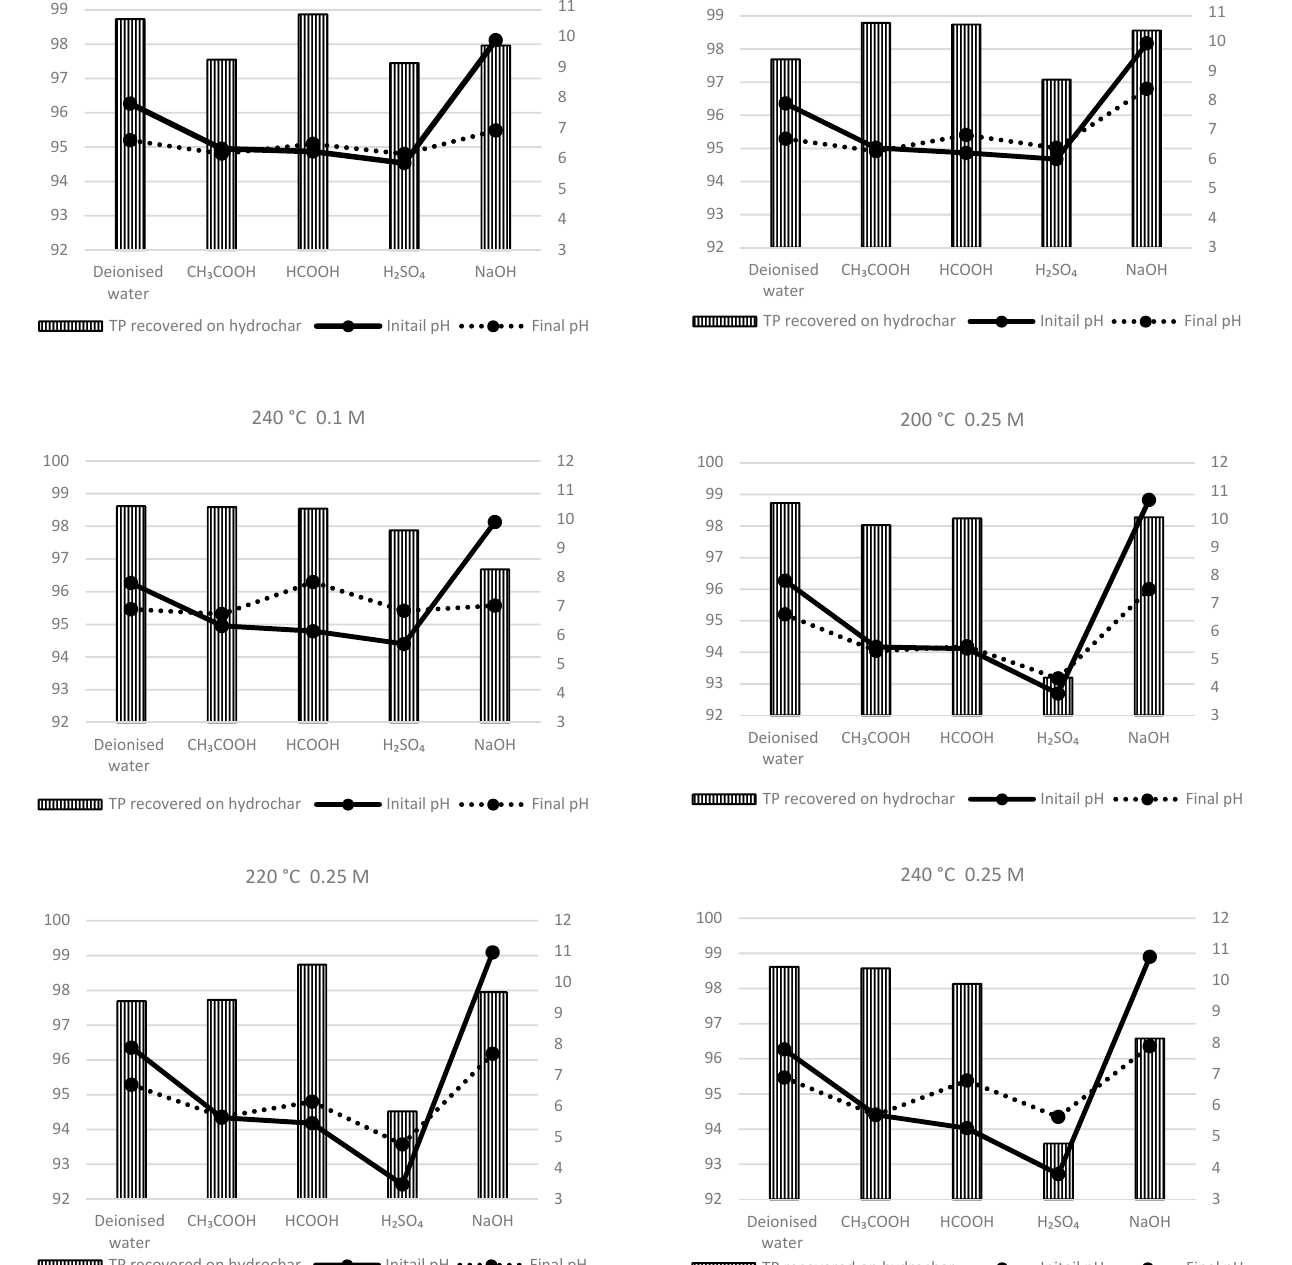
Figure 6. Influence of additives, additive concentration, temperature, and pH on the recovery percentage of TP into the hydrochar.